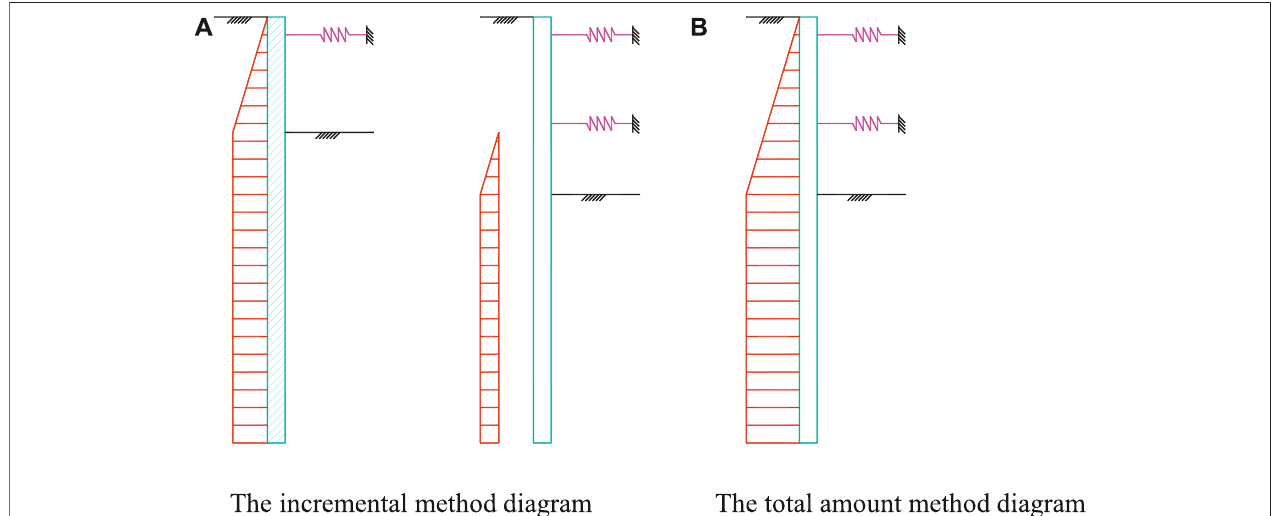
FIGURE 1 | Calculation diagram of the retaining structure section. (A) The incremental method diagram. (B) The total amount method